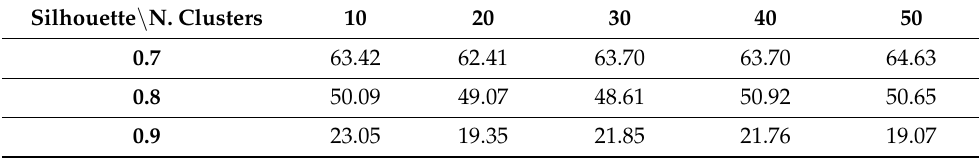
Table 56. Clustering performance in terms of silhouettes using the reduced dataset with PCA. Silhouette \ N.